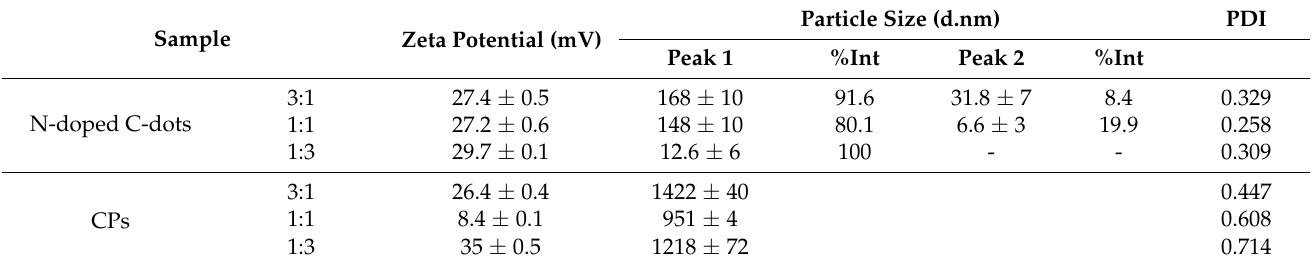
Table 1. Zeta potential, size, and polydispersity (PDI) values of CA:PVAm C-dots and CPs.